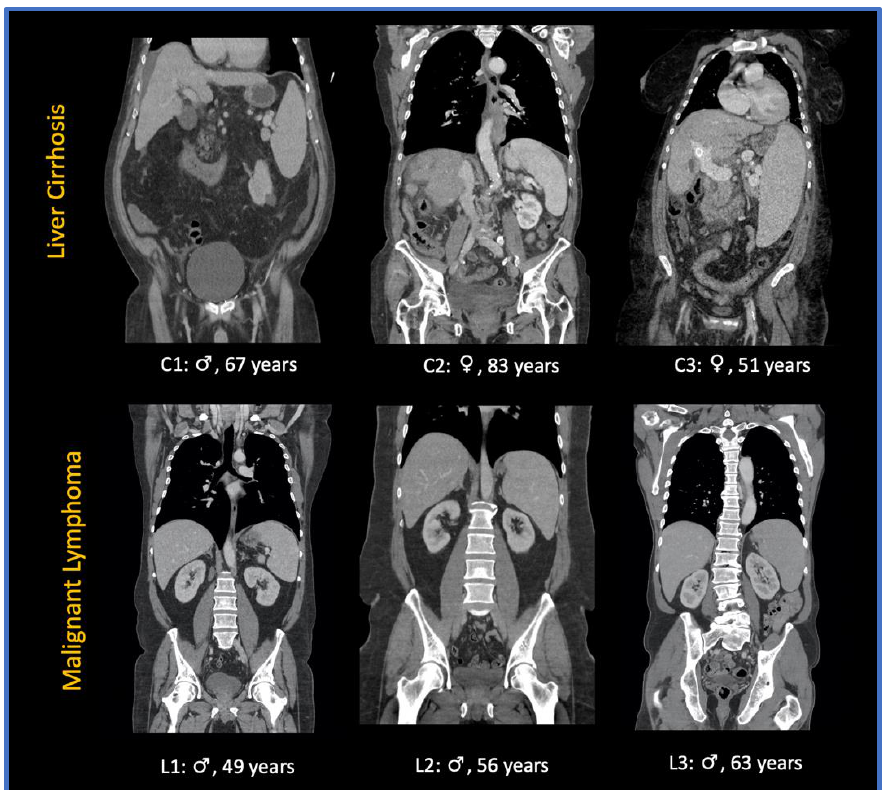
Figure 2. Sample of CT images of patients presenting with splenomegaly due to liver cirrhosis (C1-3) and splenomegaly due to malignant lymphoma (L1-3): ♀ : female patient; ♂ : male patient.